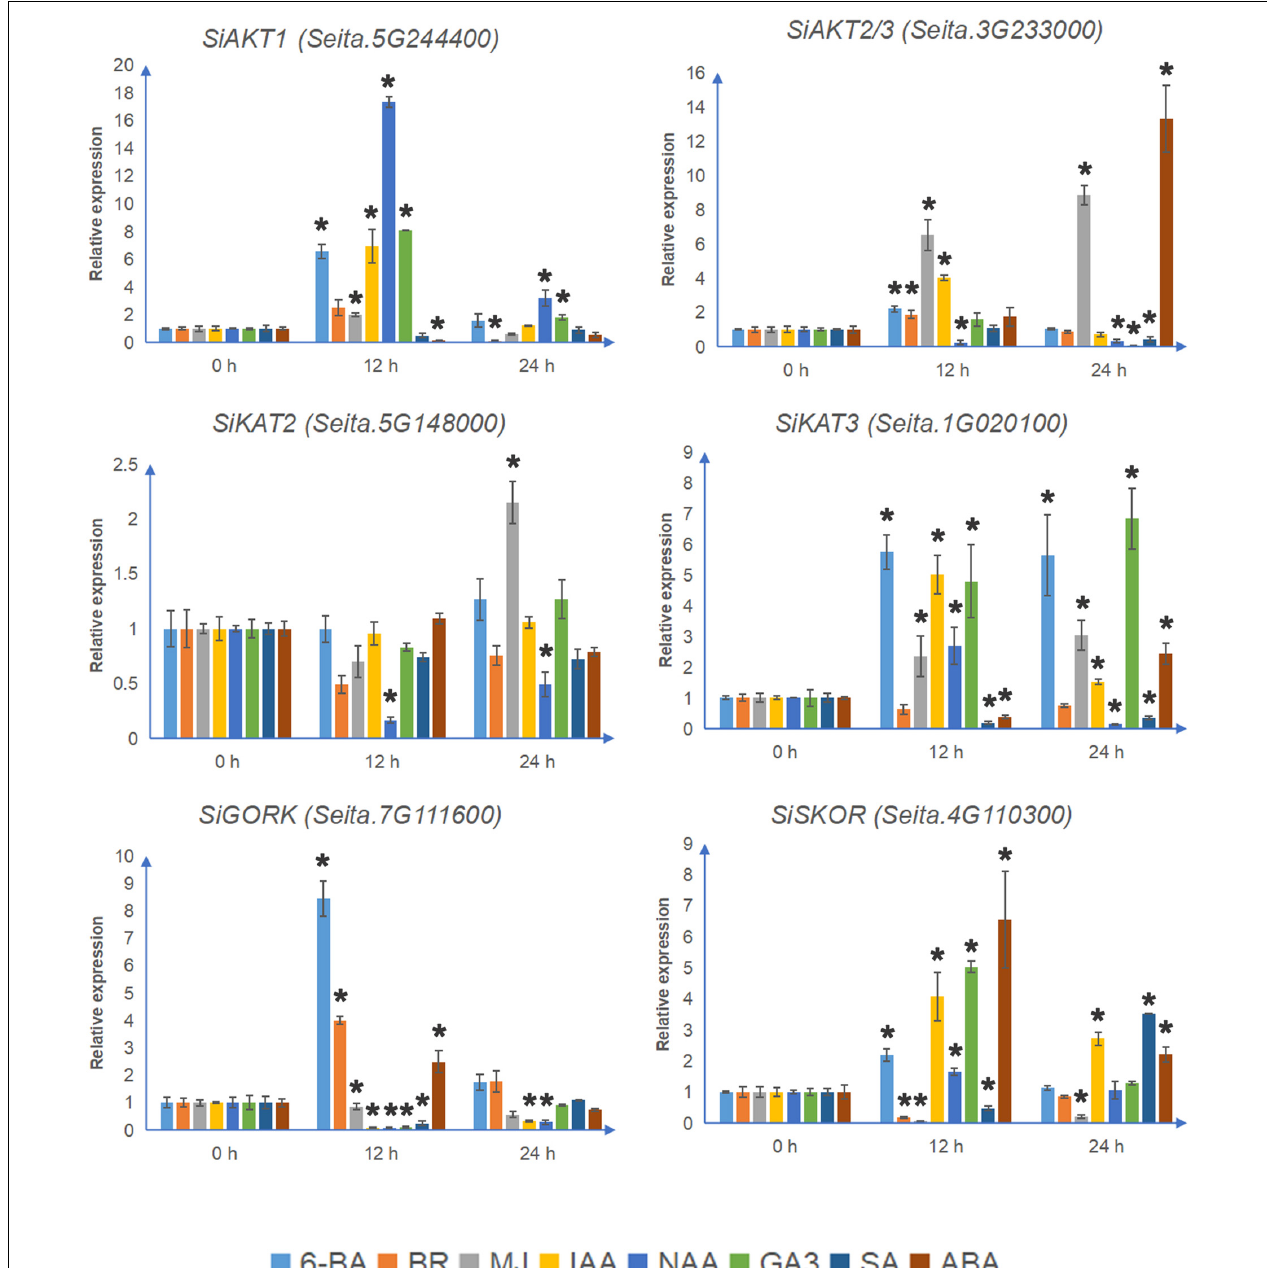
FIGURE 5 | The relative transcript levels of Shaker K + channel genes in foxtail millet under different phytohormone treatments. The qRT-PCR analyses were used to access transcript levels of Shaker K + channel genes from foxtail millet with or without 12 and 24 h ABA (100 µ mol/l), 6-BA (75 µ mol/l), IAA (10 µ mol/l), NAA (10 nmol/l), BR (100 µ mol/l), GA3 (1 mmol/l), MJ (100 µ mol/l), and SA (10 mmol/l) treatments. Each bar represents the mean ± SE normalized to SiAct2 (Seita.8G043100) . All samples were run in three biological and three technical replicates. Asterisk indicates that the gene expression under stress has a significant difference compared with the control at 0 h (* p <